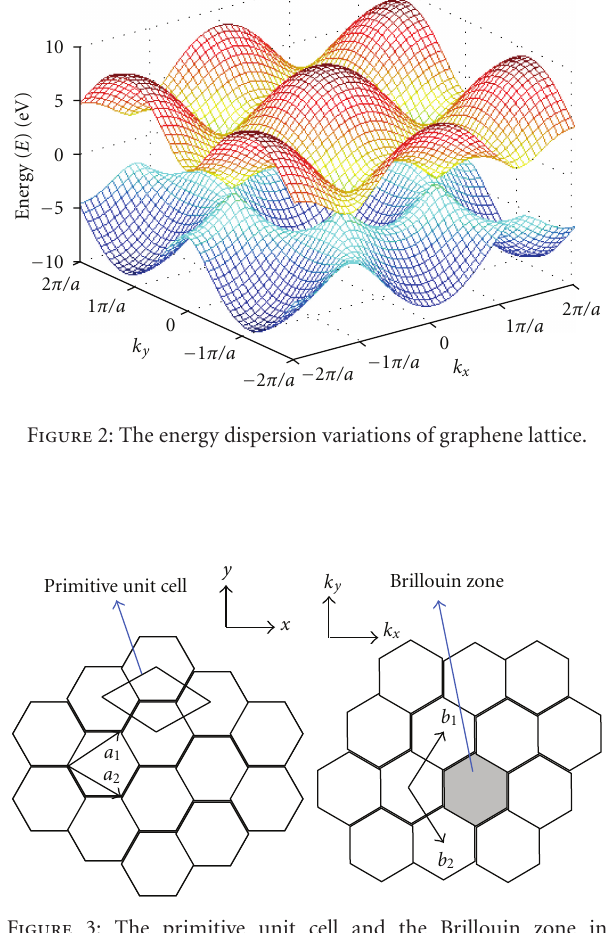
Figure 3: The primitive unit cell and the Brillouin zone in graphene.